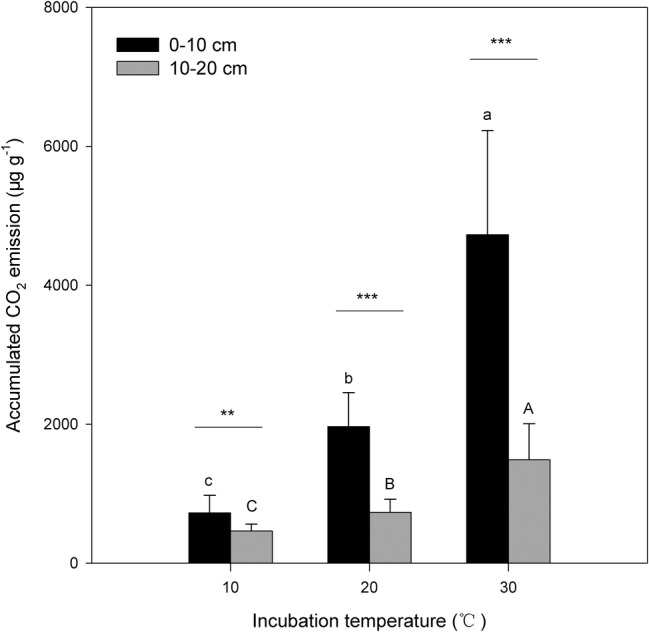
Accumulated amount of CO2 emissions from surface (0–10 cm) and subsurface (10–20 cm) soils within the investigation period. The bars are the average values, and the error bars are the standard deviations (n = 4). Different lowercase letters above the bars indicate significant differences among the temperature treatments for surface soil, while uppercase letters indicate significance for subsurface soil. Double and triple stars indicate significant differences between soils under each of the incubation temperatures at significance levels of p < 0.01 or p < 0.001, respectively.